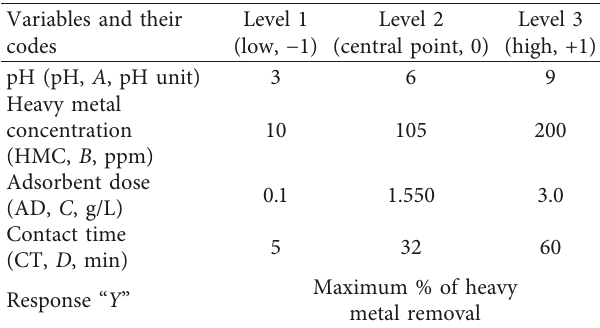
Table 2: Variables and their domains for a Plackett–Burman design (PBD) for both RPP and